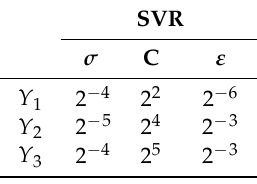
Figure 1. Schematic for SVR algorithm implementation. Table 4. Optimized parameters for the SVR model.